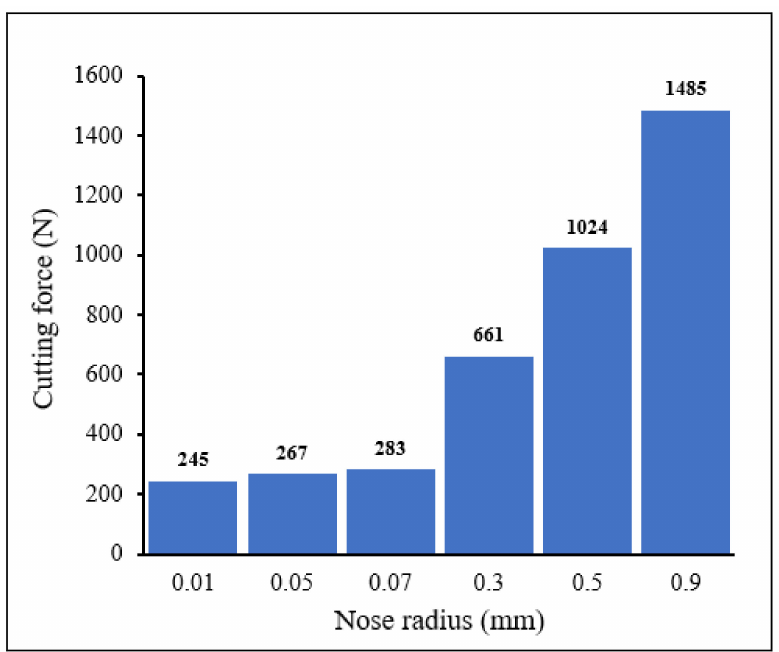
Figure 9. Distribution of cutting force for different tool nose radii V = 104 m/min, f = 0.1 mm/rev, γ = 15 ◦ .